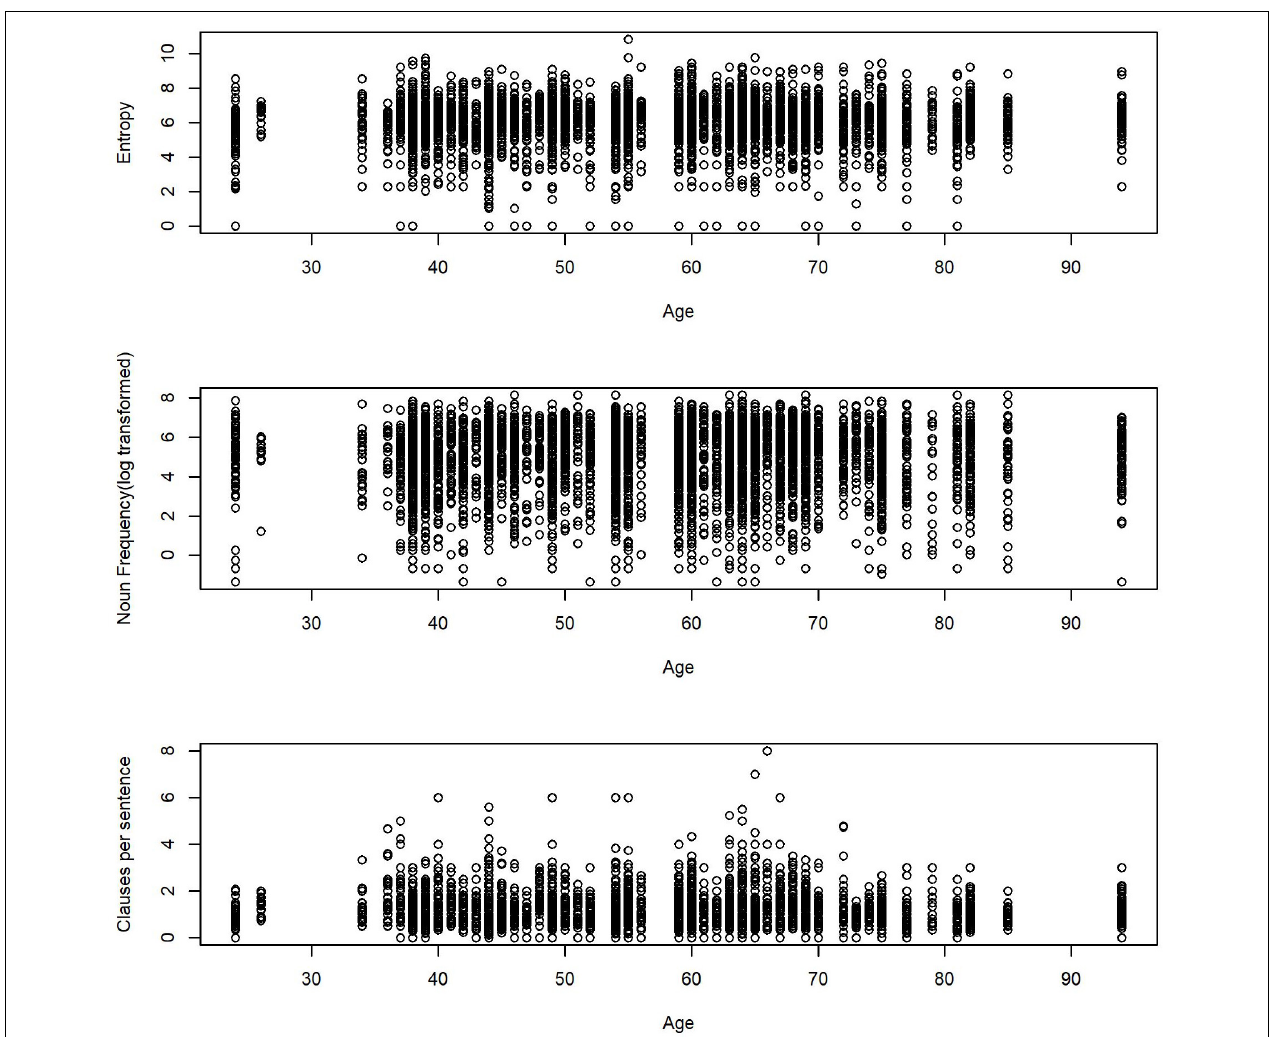
FIGURE 2 | Scatter plots for the relations between linguistic variables and